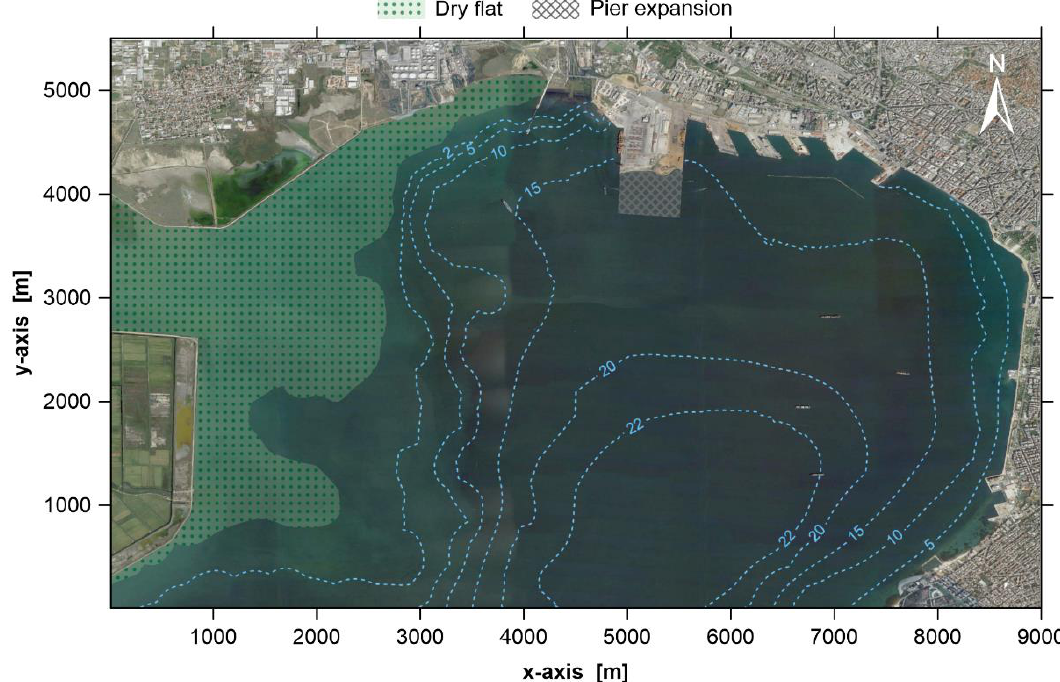
Figure 6. Model domain and bathymetry (background image from [68]; privately processed). Table 2. Scenarios used for the large-scale applications.